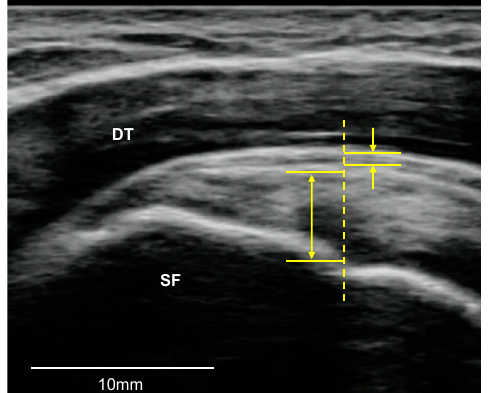
Figure 2. The measurement of the supraspinatus tendon and subacromial bursa thickness. SF, superior facet; DT, deltoid muscle.